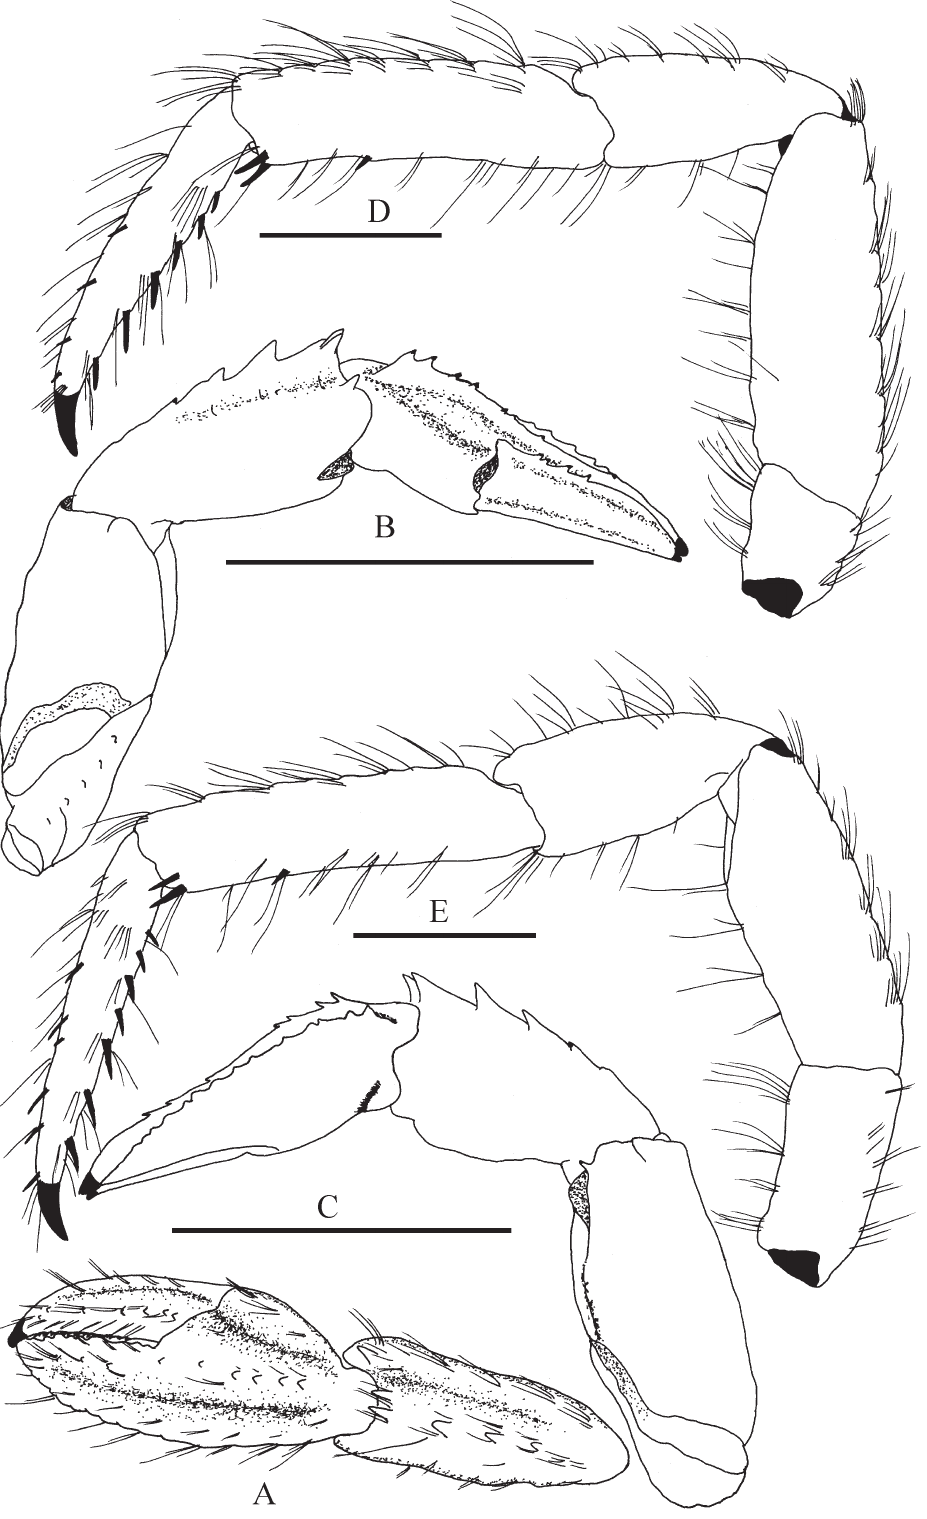
f ig . 3. – Enallopagurus spinicarpus (Glassell). Ovigerous female (SL 2.5 mm), EMU-9265, Gulf of California. A, left chela and carpus (dorsal view); B, left cheliped (mesial view, setae omitted); C, left cheliped (lateral view, setae omitted); D, right second pereopod (mesial view); E, right third pereopod (mesial view). Scale bar: 2